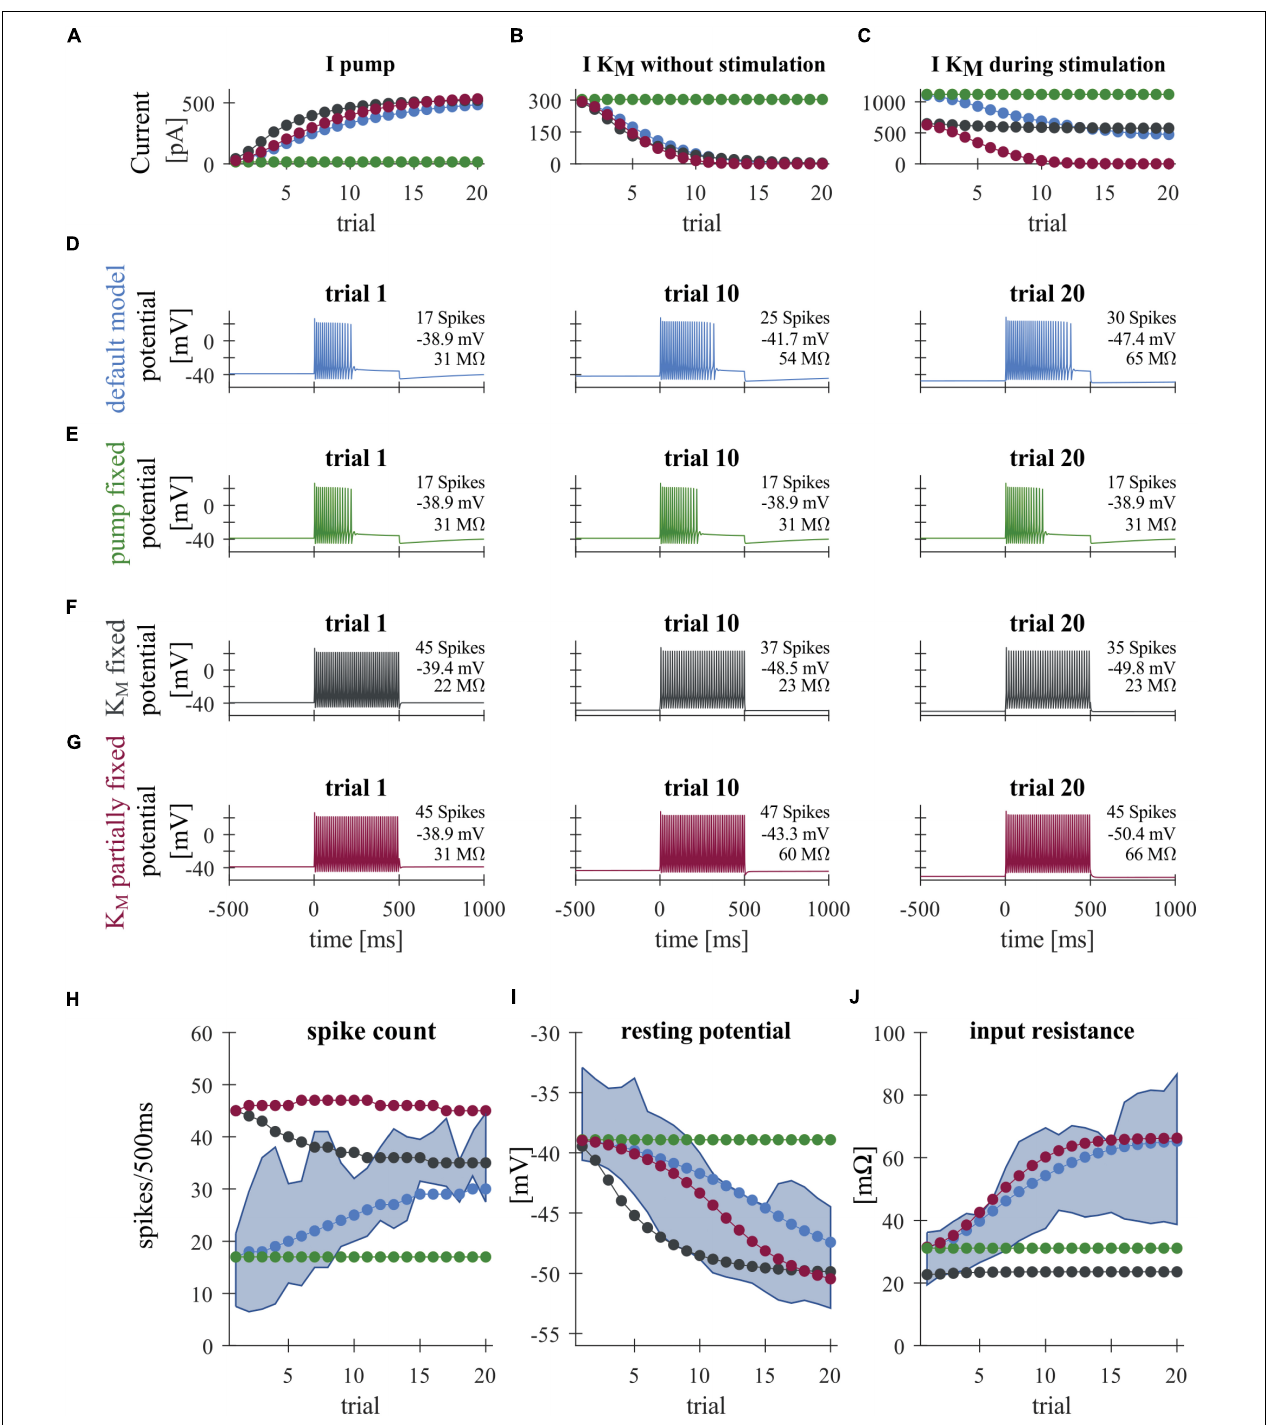
FIGURE 3 | Modeling T cell spike responses. (A) Average Na + /K + -pump current during +1 nA stimulation. (B) Average M-type K + current at 0–500 ms before the +1 nA stimulation. (C) Average M-type K + current during +1 nA stimulation. The K M current is generally larger during stimulation (C) than without stimulation (B) , because of the increased average driving voltage ( E K –V ) associated with spiking. (D–G) Responses of different T cell models to a current injection of +1 nA in Trials 1, 10 and 20. See Figure 1B for the stimulus protocol used. (D) Default model. (E) “Fixed pump model,” in which the Na + /K + -pump current I pump is fixed to the initial steady-state value. (F) “Fully fixed K M model,” in which the dynamics of the M-type K + conductance was fixed to the initial steady-state value. (G) “Partially fixed K M model,” in which the dynamics of the M-type K + conductance was fixed only during +1 nA current injection. (H–J) Simulated changes of the spike count (H) , resting potential (I) , and input resistance (J) across trials, plotted with the corresponding interquartile ranges observed experimentally (blue shading). Colors in panels (A–C) and (H–J) indicate the different model conditions: (blue) default model; (green) “fixed pump model”; (black) fully fixed K M model; and (red) “partly fixed K M model.”